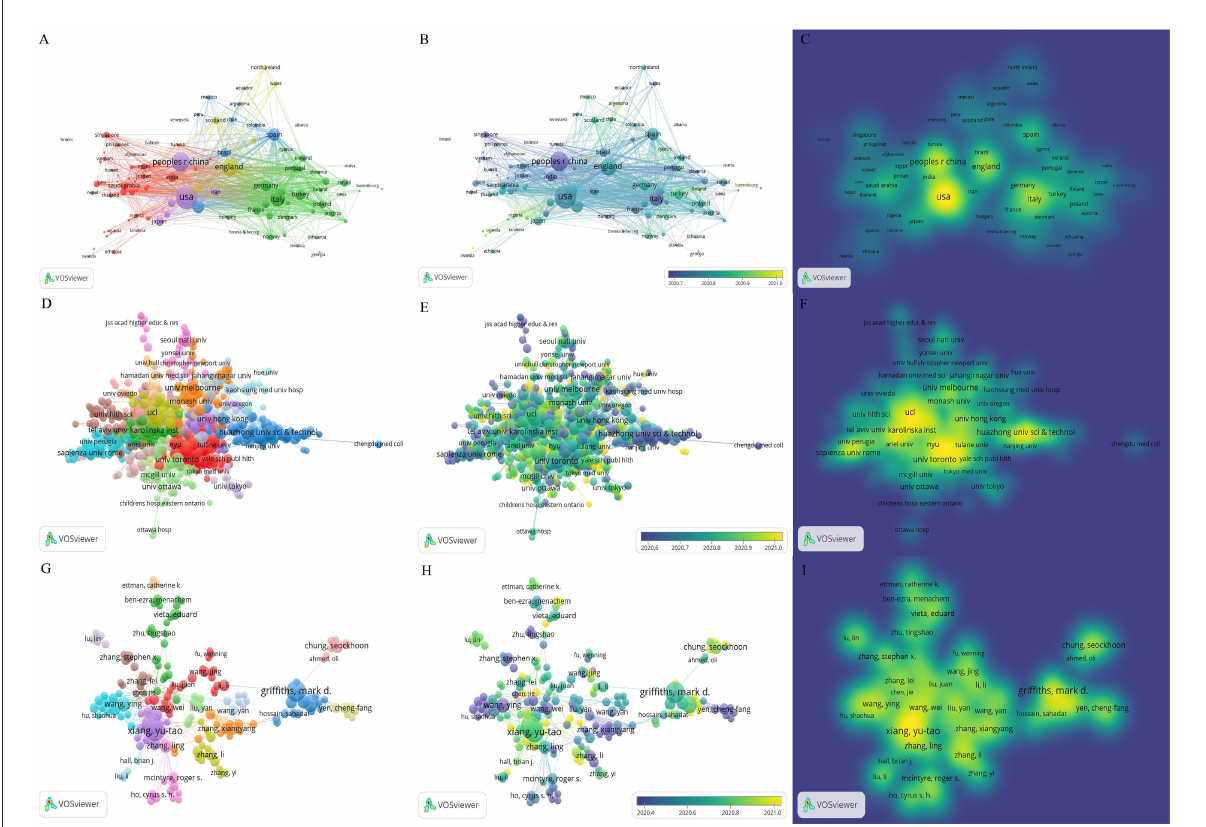
FIGURE2 The network map of countries/regions, institutes, and active authors on mental health research related to COVID-19. (A) The network visualization map of countries/regions, (B) the overlay visualization map of countries/regions, and (C) the density visualization map of countries/regions. (D) The network visualization map of institutes, (E) the overlay visualization map of institutes, and (F) the density visualization map of institutes. (G) The network visualization map of active authors, (H) the overlay visualization map of active authors, and (I) the density visualization map of active